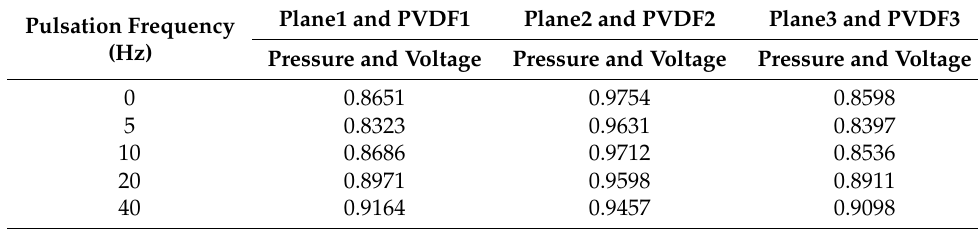
Table 4. Correlation coefficient.